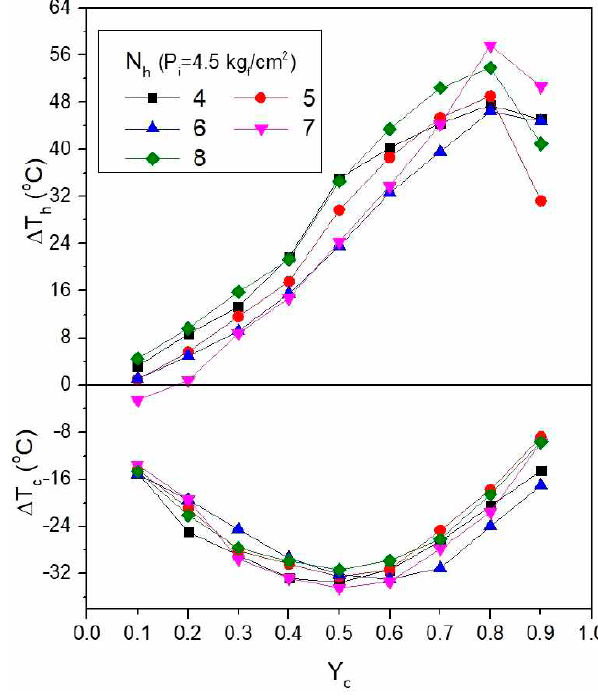
Figure 19. Temperature differences ∆ T h and ∆ T c according to inlet pressure (P i ) 4.5 kgf/cm 2 .